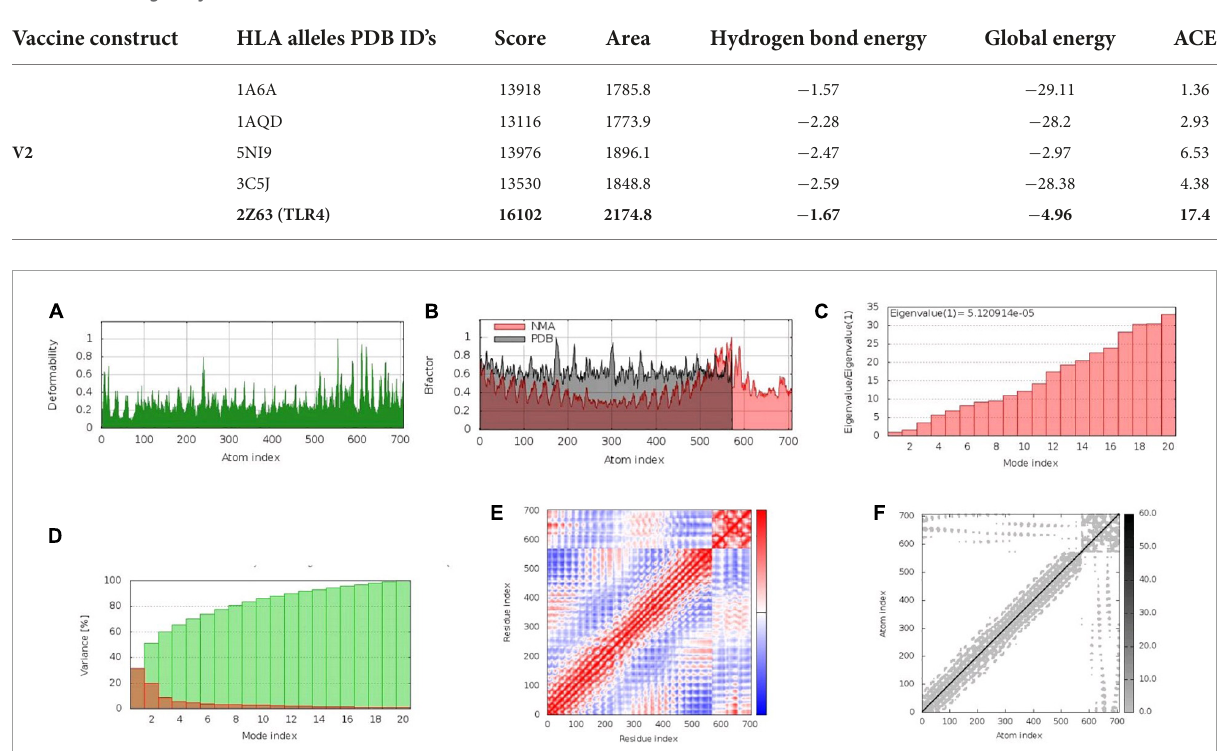
TABLE 5 Docking analysis results of the best vaccine construct (V2) with different HLA alleles. Vaccine construct